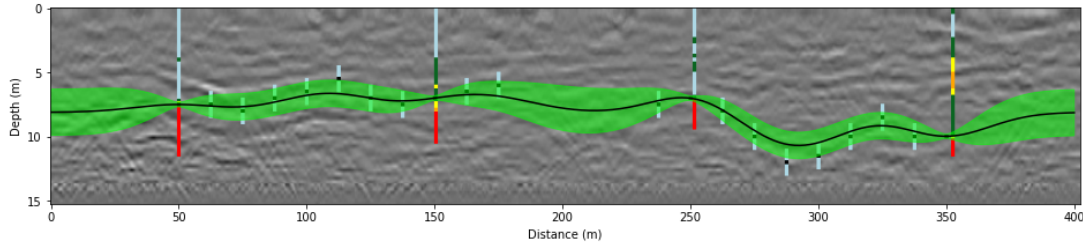
Figure 7. Resultant GP model from the geologist’s observations.